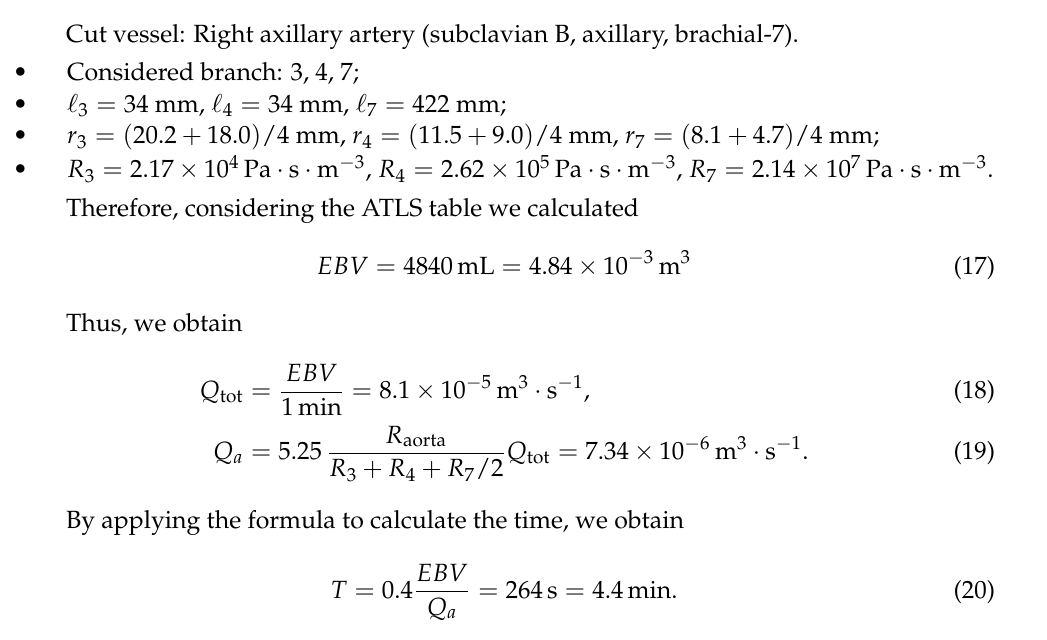
Figure 2. Anatomic representation of right axillary artery ( left panel , figure from https://en. wikipedia.org/wiki/Axillary_artery, accessed on 10 January 2023); right axillary artery injury ( right panel ) in the